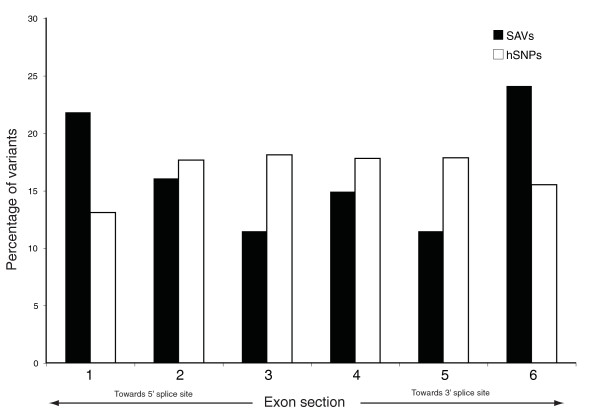
SAVs are enriched at the borders of exons. SAV and hSNP containing exons were divided into six equal sections and the proportion of variants falling into each section was plotted. While hSNPs were roughly distributed equally across the exon (with some depletion towards the edges), SAVs are significantly enriched at both edges of the exon (P = 0.005).